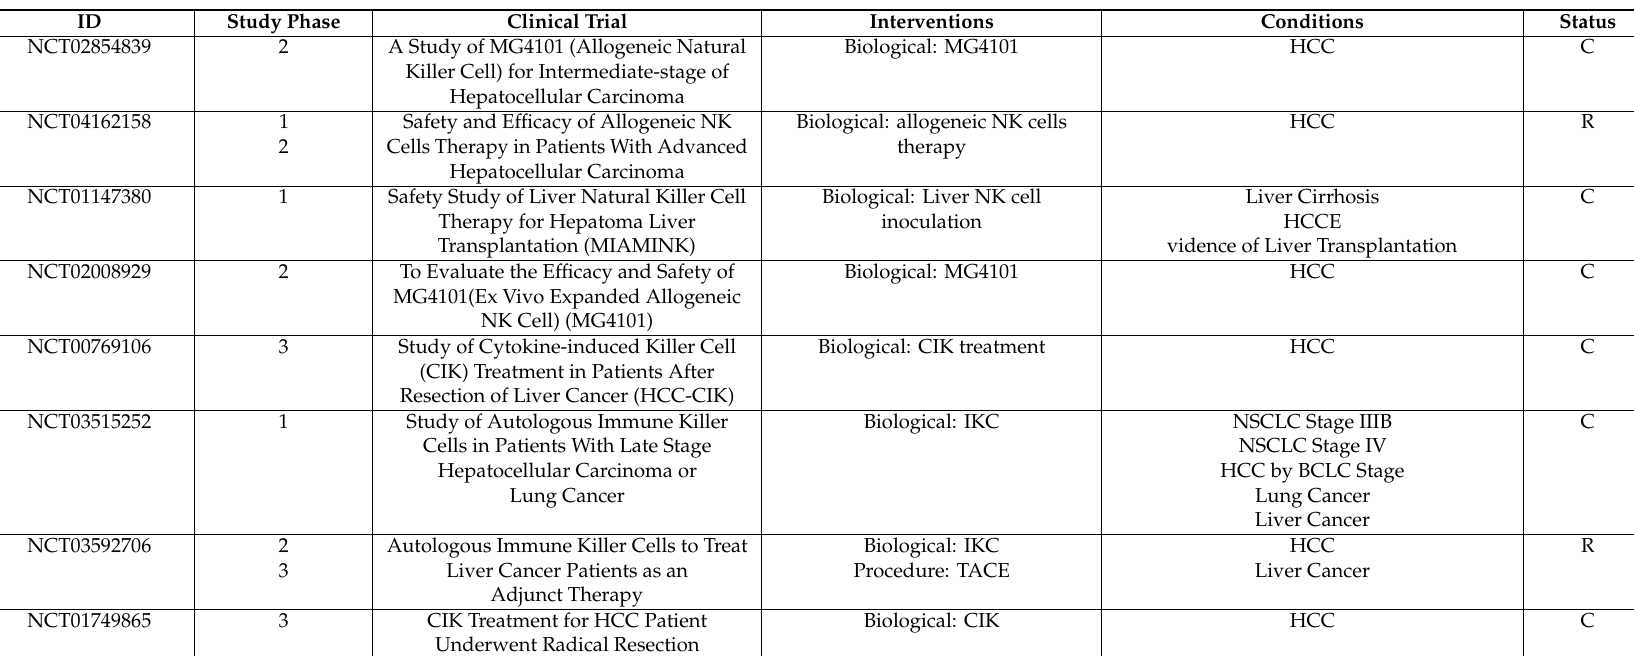
Table 1. Clinical trials for treatment of HCC involving the use of NK cells. A www.ClinicalTrials.gov search was performed using the terms “hepatocellular carcinoma” and “natural killer cells” (last updated 25 February 2020). List of abbreviations: Obser, Observational; CIK, cytokine-induced killer cell; IKC, Immune Killer Cells; TACE, Transcatheter Arterial Chemoembolization; NKT, Natural Killer T; HCC, Hepatocellular Carcinoma; NSCLC, Non-Small Cell Lung Cancer; SCLC,